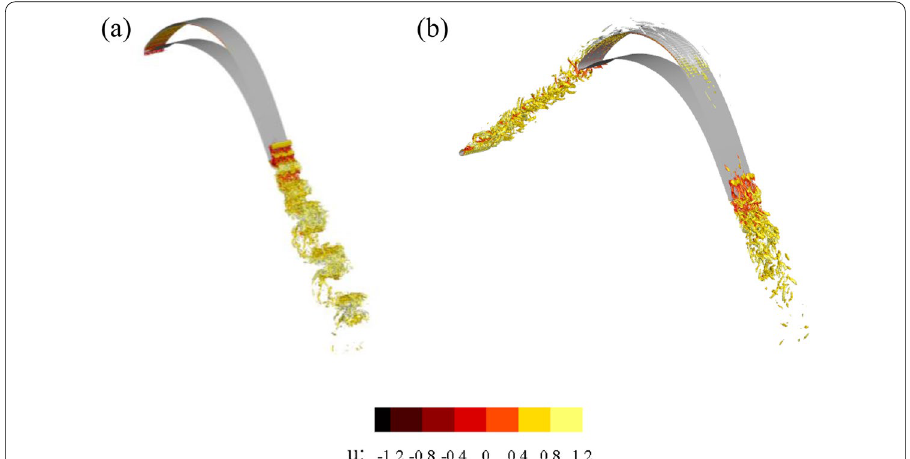
Fig. 10 Instantaneous isosurfaces of Q-contoured by velocity magnitude: ( a ) uniform inflow; ( b ) disturbed inflow